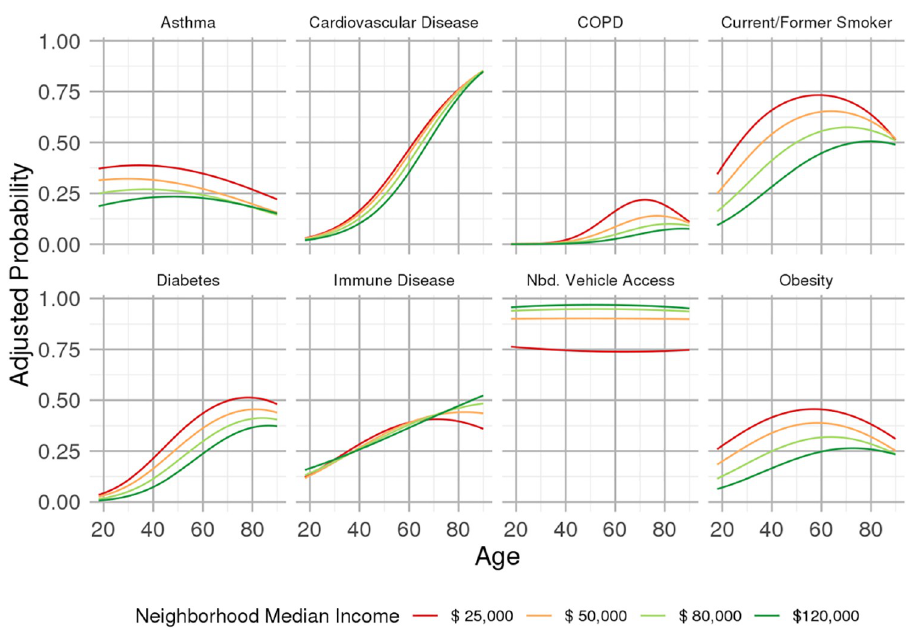
Fig 3. Prevalence of selected comorbid conditions and proportion of households in patients’ respective neighborhood of residence owning at least one vehicle, as a function of age, for groups of patients defined according to selected levels of median neighborhood income. Estimates adjusted to the modal race/ethnicity (non- Hispanic White). Estimates for cardiovascular disease adjusted to modal values of other predictors in the model, i.e., non-diabetic, non-obese, no autoimmune disease, and no documented smoking history. Similarly, estimates for COPD adjusted to no documented smoking history.